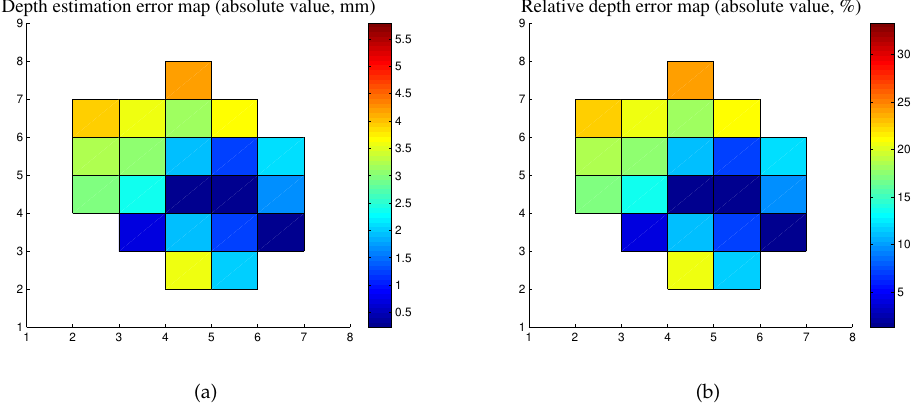
Figure 13. Depth estimation error distribution of the specular highlight region. ( a ) Depth estimation error map (absolute value). ( b ) Relative depth error map (absolute